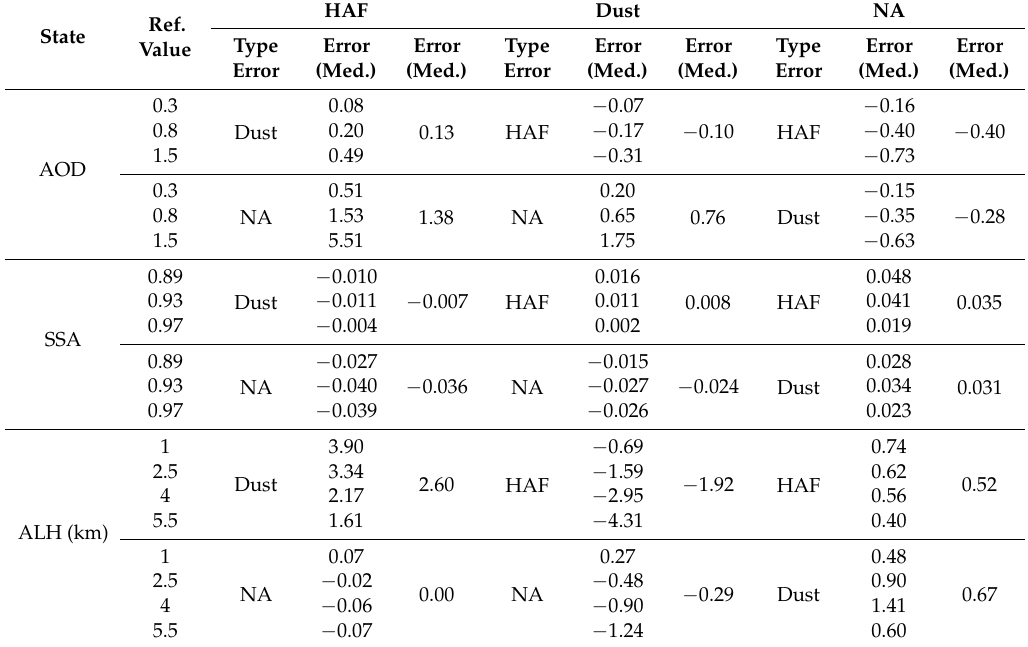
Table 6. Median values of the data plotted in Figure 13. Errors are the median retrieval error obtained by comparing retrieved values from the developed algorithm with the reference condition, assuming a different aerosol type than that used in the radiance